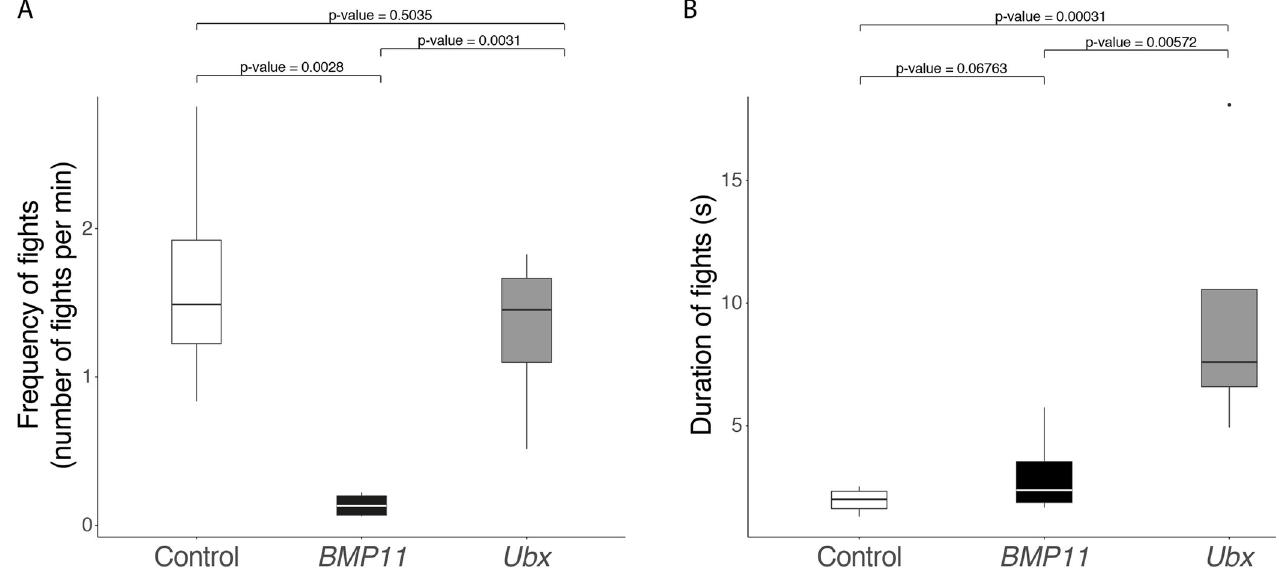
Fig 4. Effects of BMP11 and Ubx RNAi on male fighting behavior. (A) Effect of BMP11 and Ubx knockdowns on male fighting frequency (number of fights per unit of time) compared to control individuals. (B) Effect of BMP11 and Ubx knockdowns on male fighting duration compared to control individuals. The data underlying this figure may be found in S8 and S9 Tables. BMP11, Bone Morphogenetic Protein 11 ; RNAi, RNA interference; Ubx , Ultrabithorax .